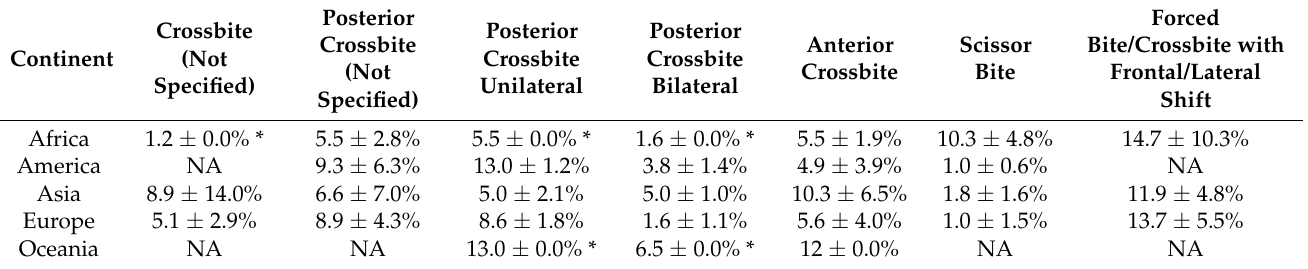
Table 5. Prevalence of different transversal malocclusions and anterior crossbite according to geo- graphical location.